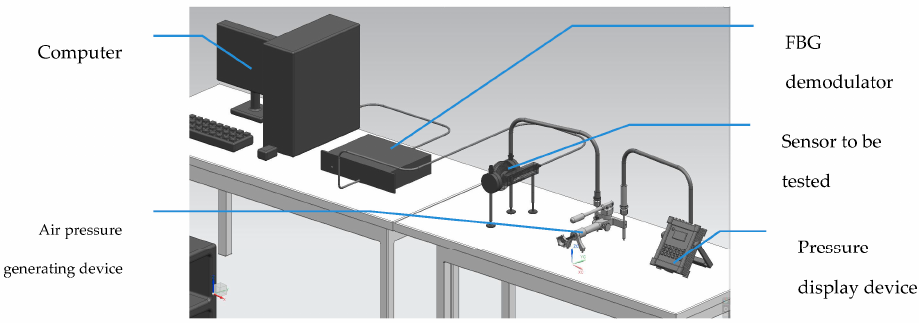
Figure 9. The test system of sensor.